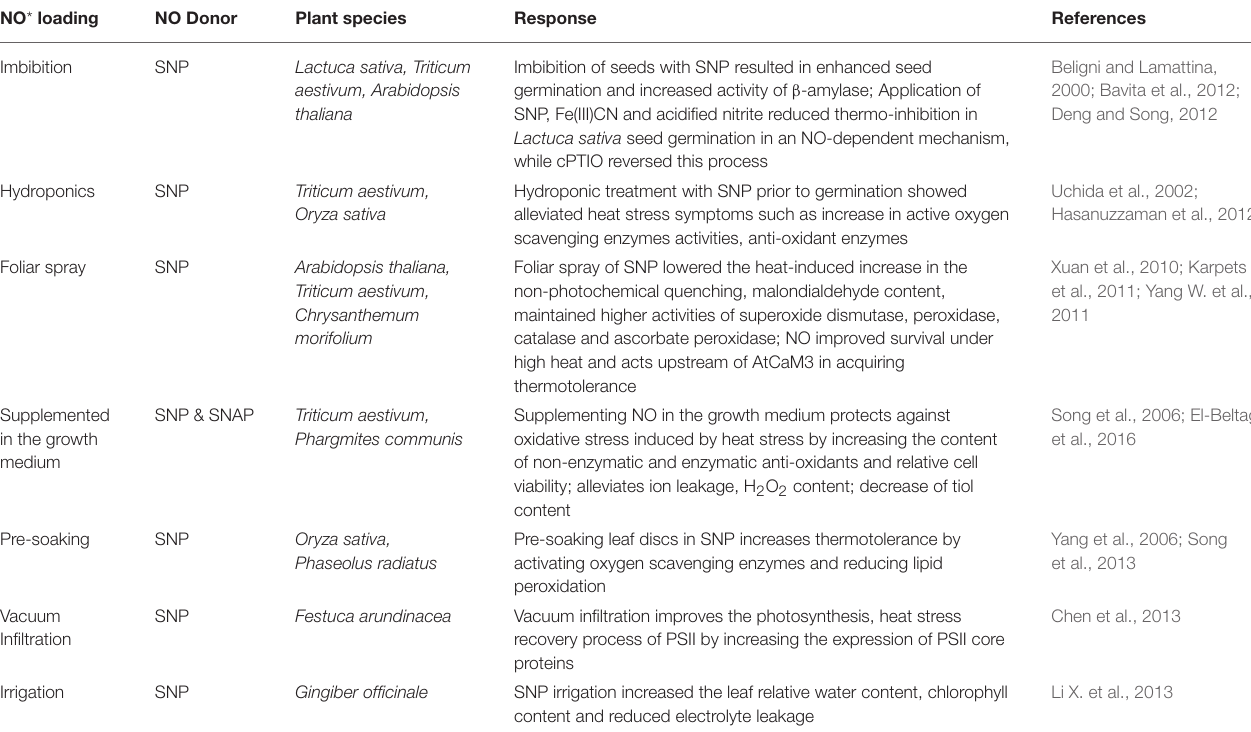
TABLE 2 | Various methods deployed for exogenous nitric oxide treatment in plant heat stress